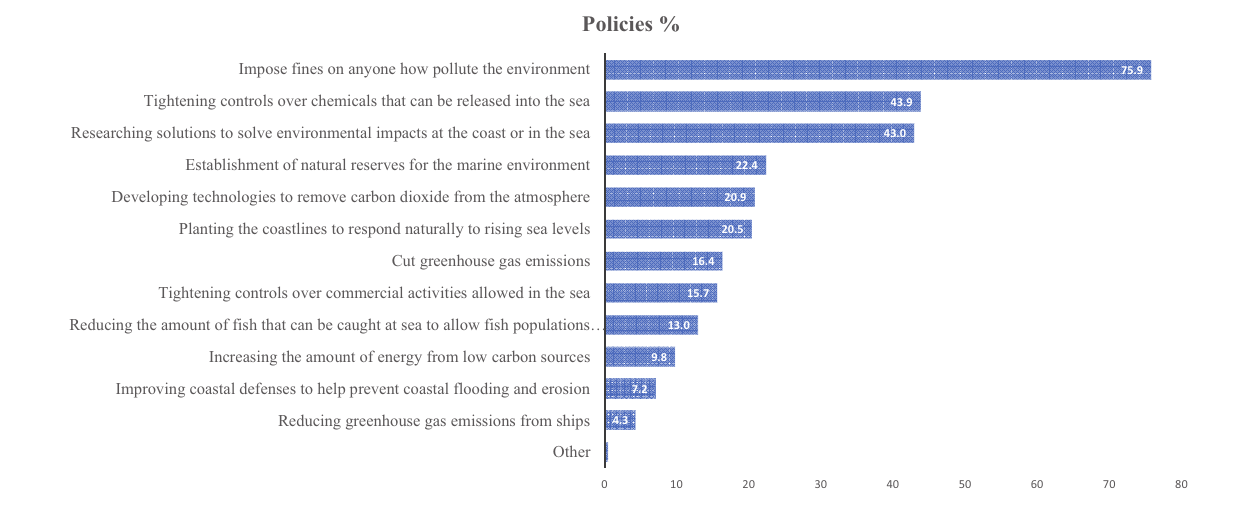
FIGURE 9 | Responses to the question: If you had to decide what marine policies should be prioritized by the government, which three would you select from the list